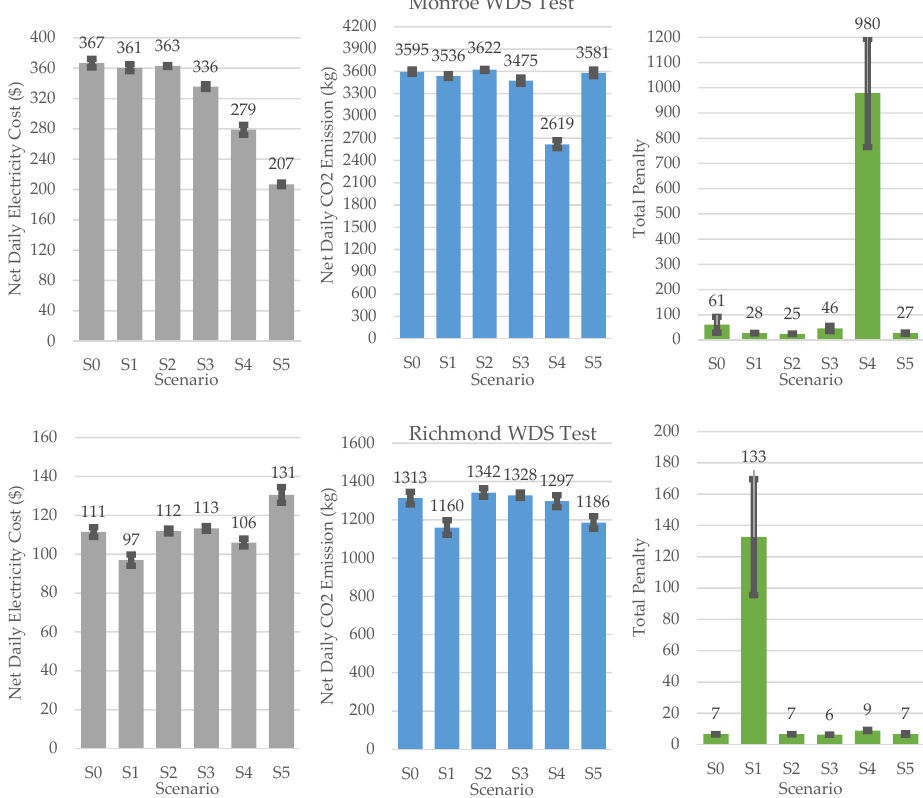
Figure 2. Electricity cost (left), CO 2 emissions (middle) and total penalty (right) results of five scenarios of Monroe WDS (top) and Richmond skeletonized WDS (bottom) tests.